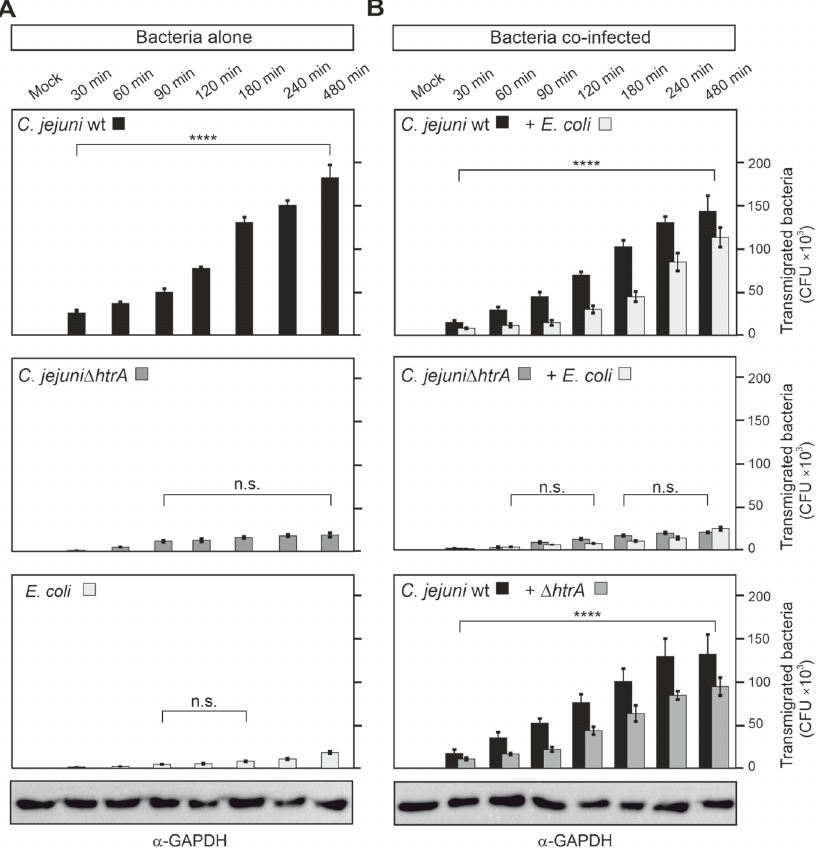
Figure 4. Time course of transmigration properties of C. jejuni and E. coli bacteria across polarized Caco-2 cells using a transwell filter system. Caco-2 cells were cultivated for 14 days to form polarized monolayers on transwell filters and then infected with the indicated single bacterial strains ( A ) or mixed bacterial strains ( B ) at an MOI of 25 each. Transmigrated bacteria were collected from the bottom chambers, and C. jejuni were cultivated on Campylobacter agar plates and E. coli on LB agar plates, respectively. Finally, the CFUs were quantified in triplicate. On the bottom are two represen- tative GAPDH blots as loading controls. Significant differences shown in the graphs correspond to p ≤ 0.0001 (****) or non-significant